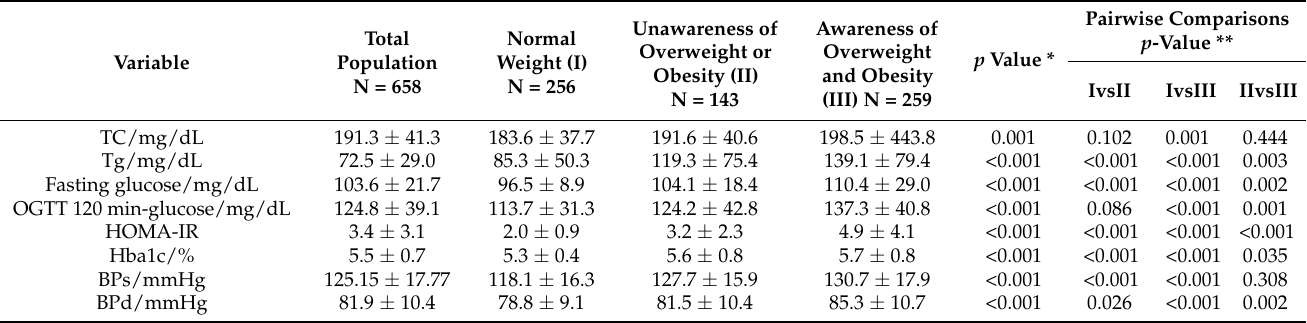
Table 4. Clinical and biochemical characteristics of the study population.